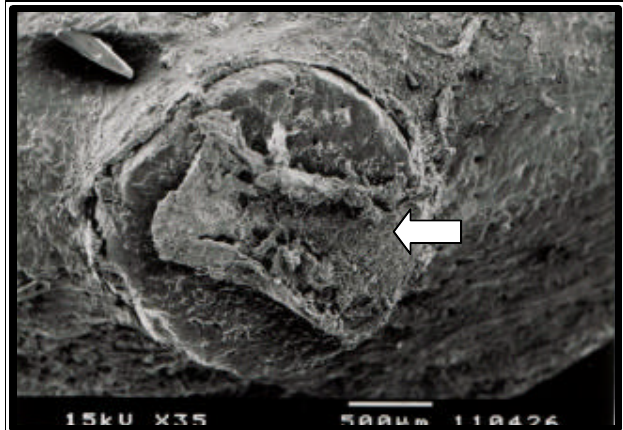
FIGURA 4 - Eletromicrografia de varredura do implante à base de fosfato de cálcio, em rádio de coelhos. Observar o recobrimento parcial por tecido ósseo (seta). (Tempo do pós operatório: 12 semanas; aumento